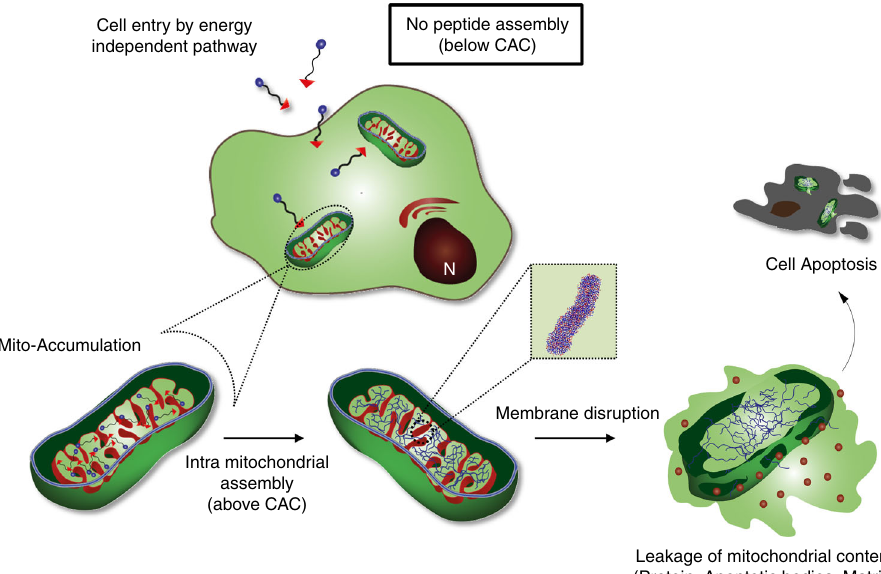
Fig. 1 Intra-mitochondrial assembly of Mito-FF. The self-assembly process is driven by the increased mitochondrial membrane potential of cancer cells, leading to high mitochondrial accumulation of Mito-FF followed by self-assembly into fi brils. The intra mitochondrial fi brils further disrupt the membrane, resulting in leakage of mitochondrial contents to the cytosol, which eventually induces cellular